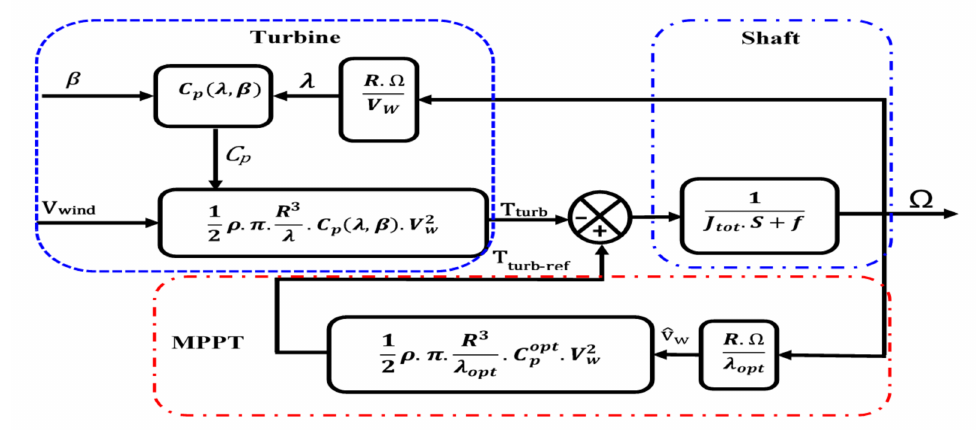
Figure 2. Turbine and MPPT